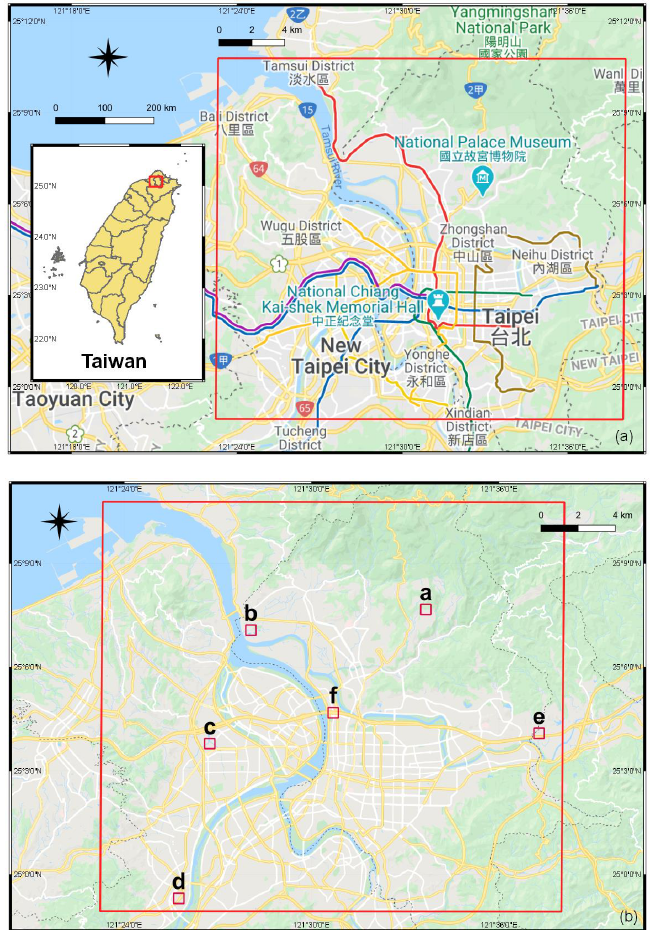
Figure 6. The study area is located in Taipei, Taiwan. ( a ) Comprehensive roadmap with a large red rectangle where the study area is located; ( b ) filtered roadmap with six sample tiles indicated in small red squares and by letters a through f. Table 2. The numbers of images of training, validation and test sets for the experiments.